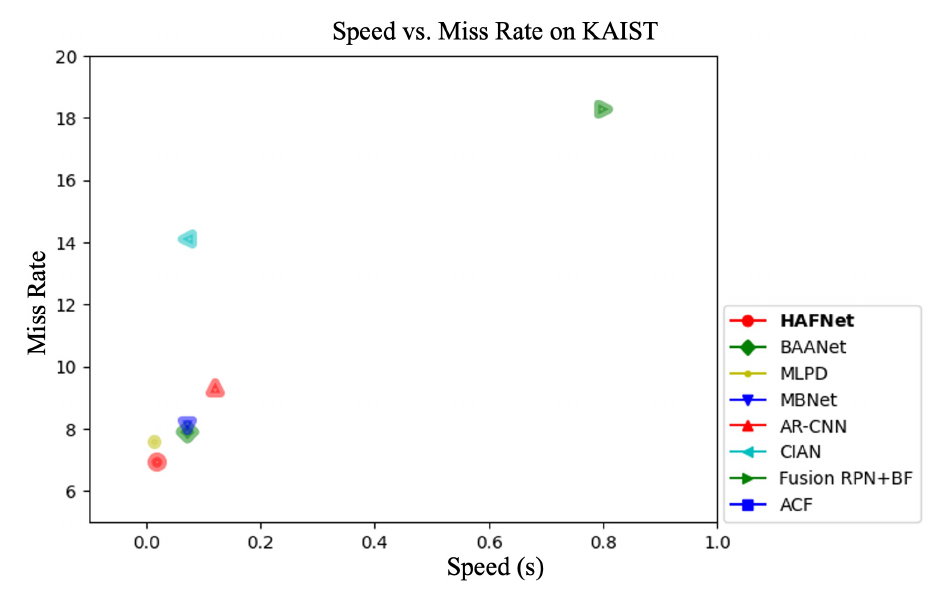
Figure 5. Visualizing the performance comparison of baseline and proposed HAFNet detection models under three distinct occlusion scenarios: none, partial, and heavy. ( a ) Ground truth of the visible-thermal image pairs. ( b ) Results of the baseline. ( c ) Results of our HAFNet. ( d ) Attention maps of our HAFNet.